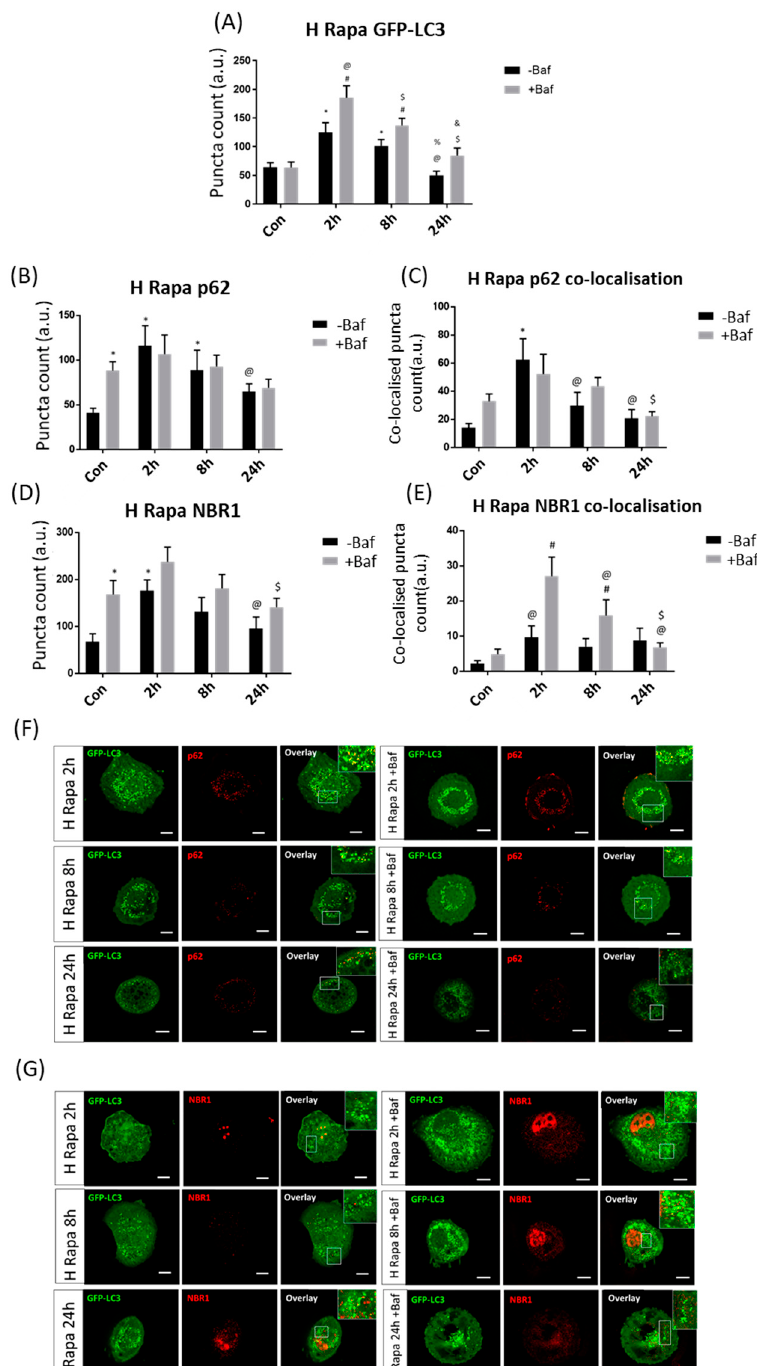
Figure 3. Puncta count analysis following 1 µ M rapamycin (H Rapa) over 24 h in the presence (+Baf) and absence ( − Baf) of bafilomycin. ( A ) Total GFP-LC3 puncta analysis. N = 24. * p < 0.05 vs. Con, # p < 0.05 vs. Con +Baf, @ p < 0.05 2 h − Baf, $ p < 0.05 vs. 2 h +Baf, % p < 0.05 vs. 8 h − Baf, & p < 0.05 vs. 8 h +Baf. ( B ) Total p62 puncta analysis. N = 12. * p < 0.05 vs. Con, @ p < 0.05 vs. 2 h − Baf. ( C ) Co-localised GFP-LC3/p62 puncta analysis. N = 12. * p < 0.05 vs. Con, @ p < 0.05 vs. 2 h − Baf, $ p < 0.05 vs. 2 h +Baf. ( D ) Total NBR1 puncta analysis. N = 12. * p < 0.05 vs. Con, @ p < 0.05 vs. 2 h − Baf, $ p < 0.05 vs. 2 h +Baf. ( E ) Co-localised GFP-LC3/NBR1 puncta analysis. # p < 0.05 vs. Con +Baf, @ p < 0.05 2 h − Baf, $ p < 0.05 vs. 8 h +Baf. ( F ) Representative fluorescence micrographs showing GFP-LC3 and p62 puncta. ( G ) Representa-tive fluorescence micrographs showing GFP-LC3 and NBR1 puncta. Scale bar = 10 µ